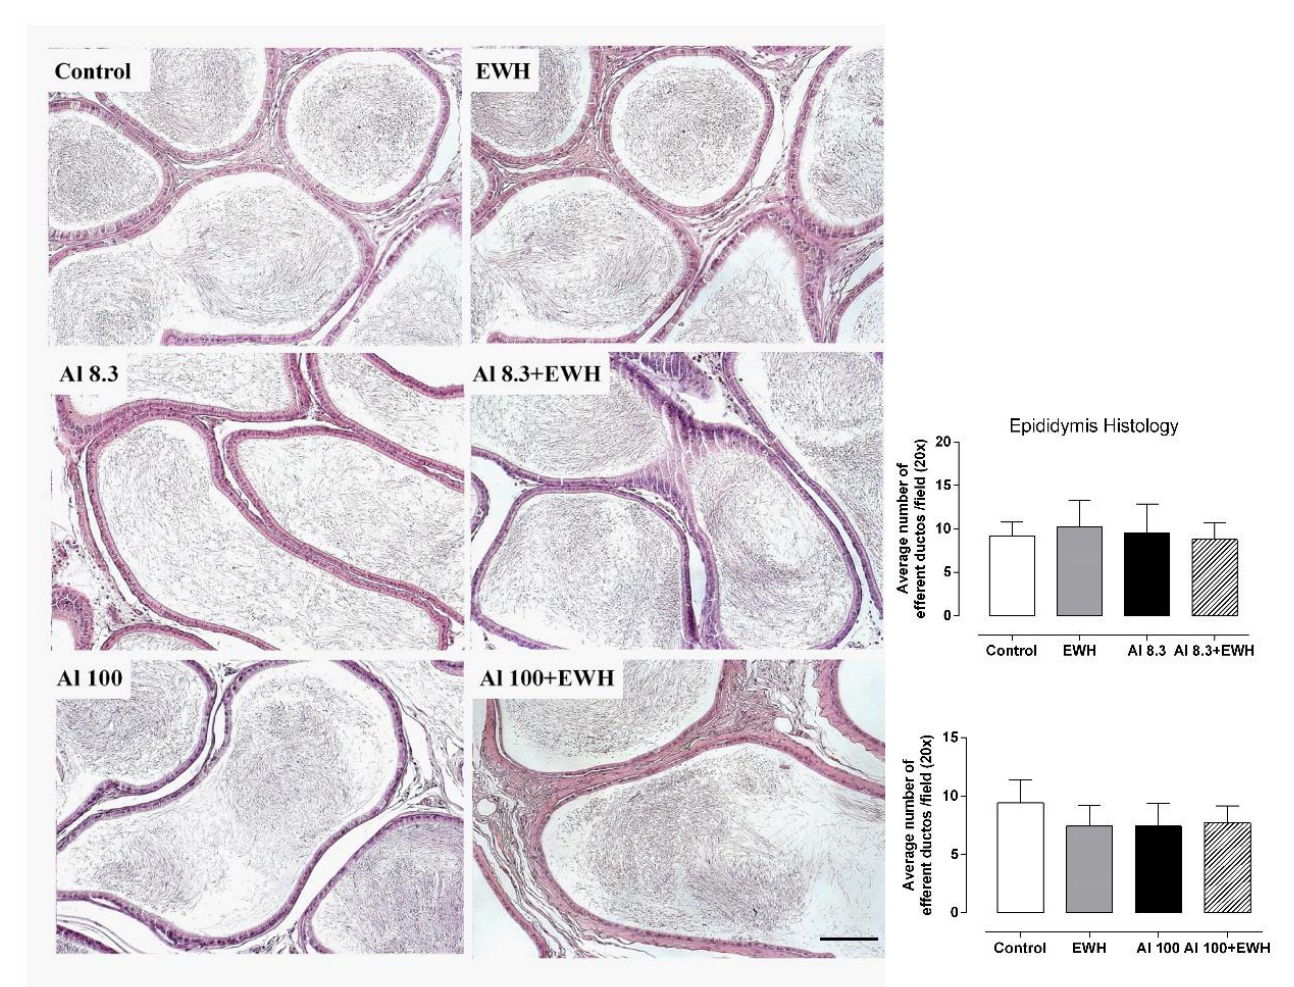
Figure 4. Effect of EWH on epididymis histopathology of rats exposed to AlCl 3 at 8.3 and 100 mg/kg b.w. per day . Epididymis sections show normal histology for all groups. Scale bar: 50 µm. Graphs: Average number of empty efferent ducts per field (20 × ). Data are expressed as mean ± SEM, n = 6 (two-way ANOVA and Bonferroni as post-hoc